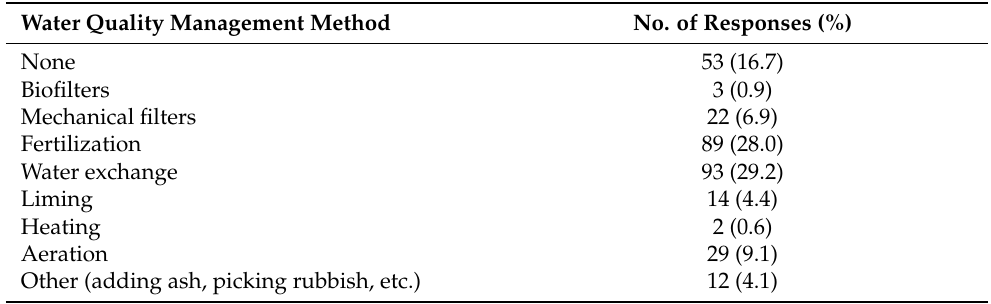
Table 5. Water quality methods employed by fish farmers in the studied districts of the Rwenzori